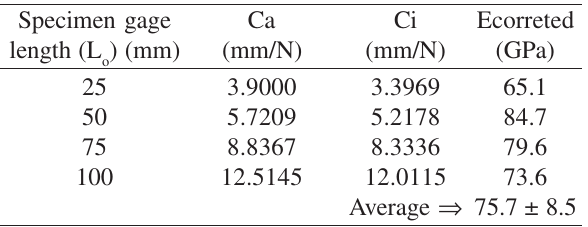
/A ) for each gage length tested, for carbon fibres and glass fibres. o o